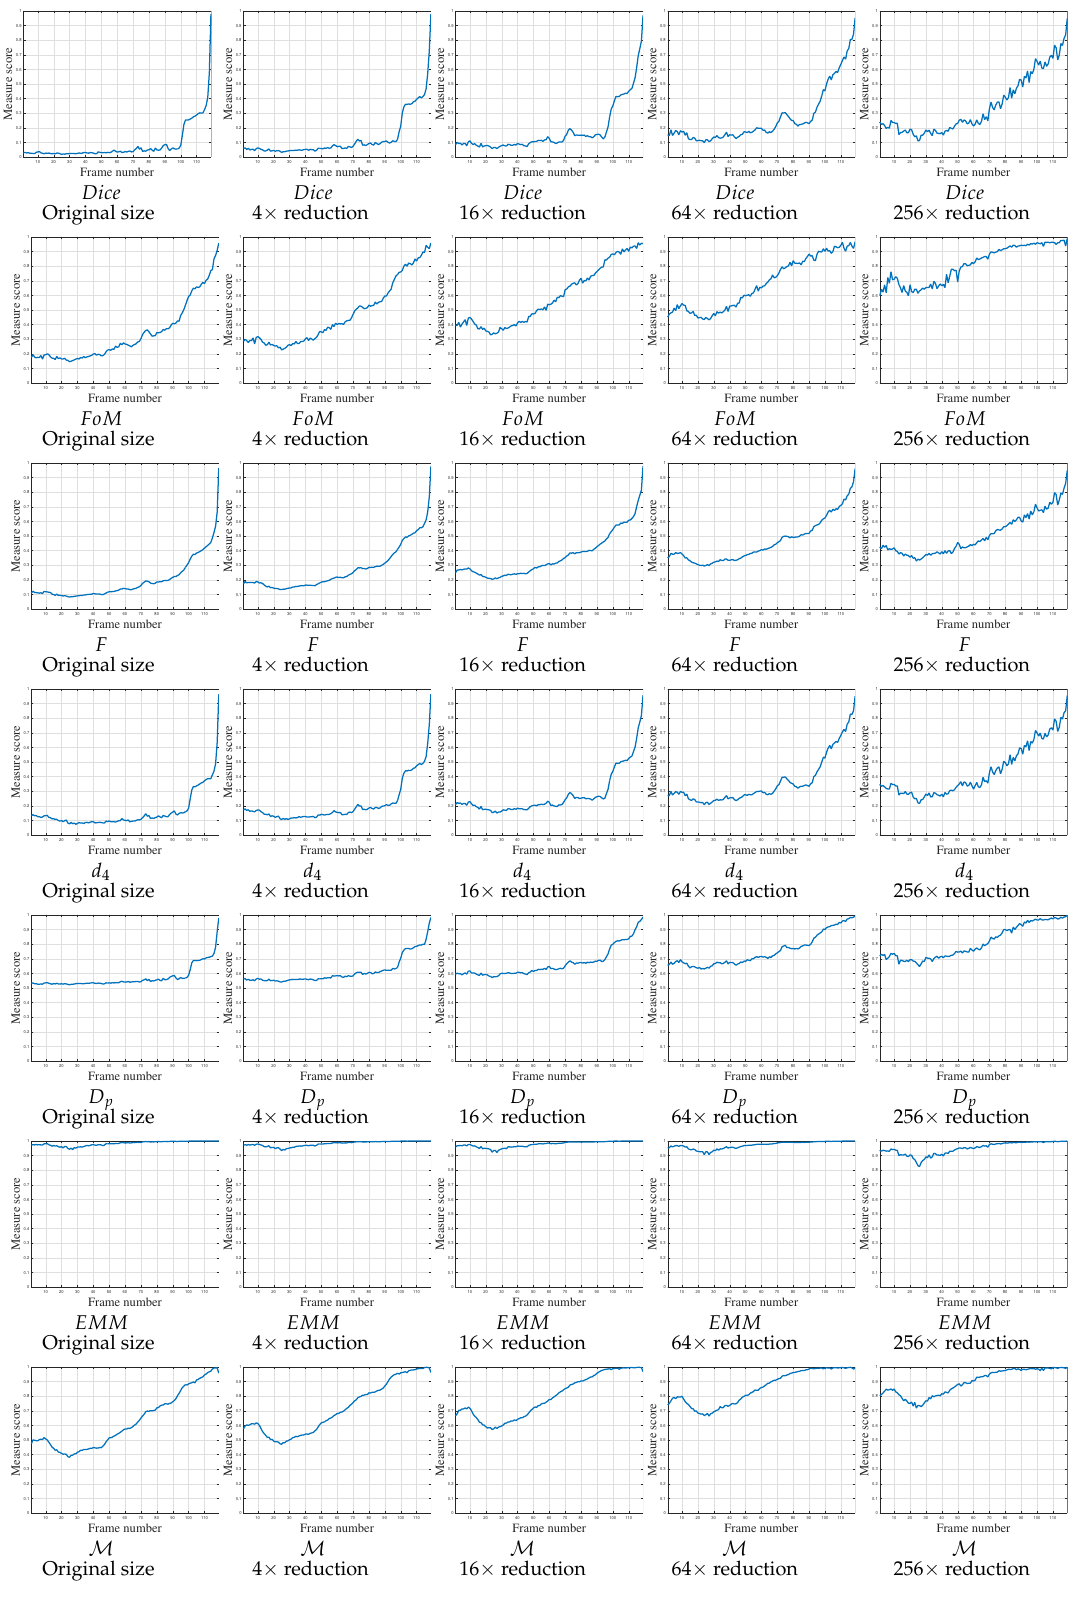
Figure 10. Localization metrics behaviors on real experiment concerning video 2 (V2) of 119 frames. The parameter concerning FoM , F , d 4 and D p is κ = 1/9. Concerning M , the parameters are µ FP = 1/ ∆ 2 and µ FN = 1/ ∆ , so µ FP < µ FN